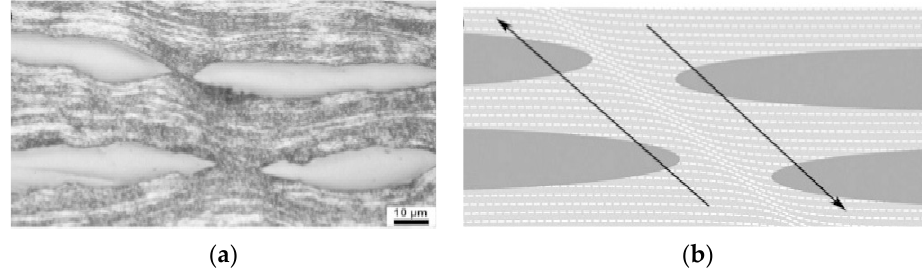
Figure 9. ( a ) Shear band formation within the composite after three ARB cycles. ( b ) Schematic illustration of segmentation mechanism at a shear band. Reprinted with permission from ref. [86]. Copyright 2017 Elsevier.